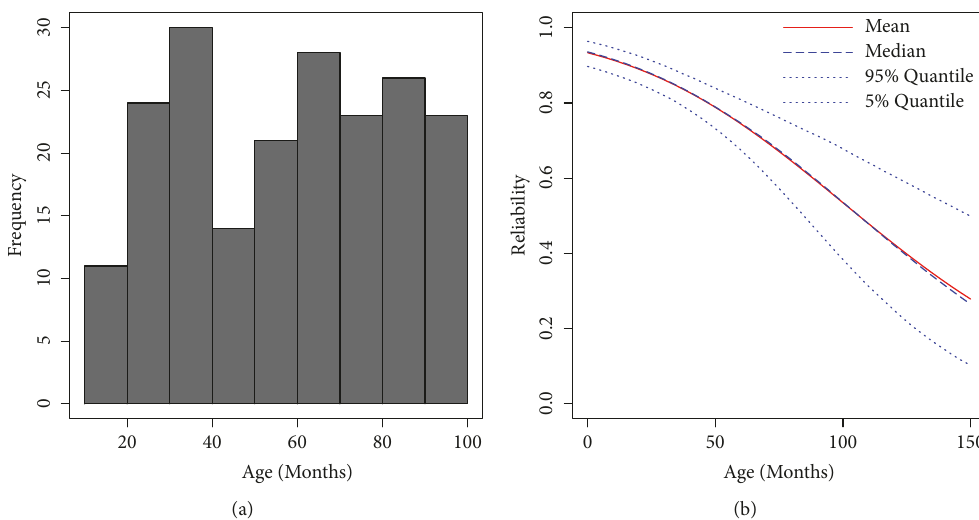
Figure 1: (a) Current age distribution for the stockpile of 200 units to be used; (b) Summary of posterior reliability distribution as a function of the age of the